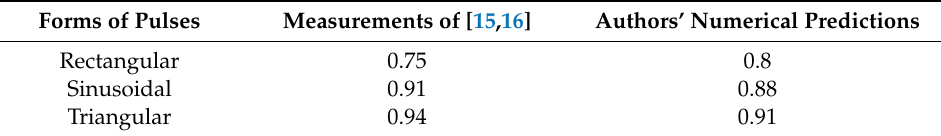
Table 1. Measured and predicted values of Nusselt number at the stagnation point. Forms of Pulses